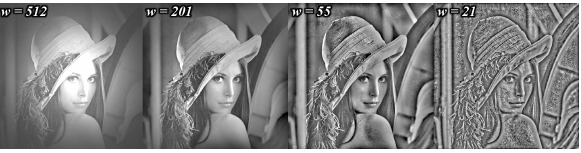
Figure 4: Wallis filtering